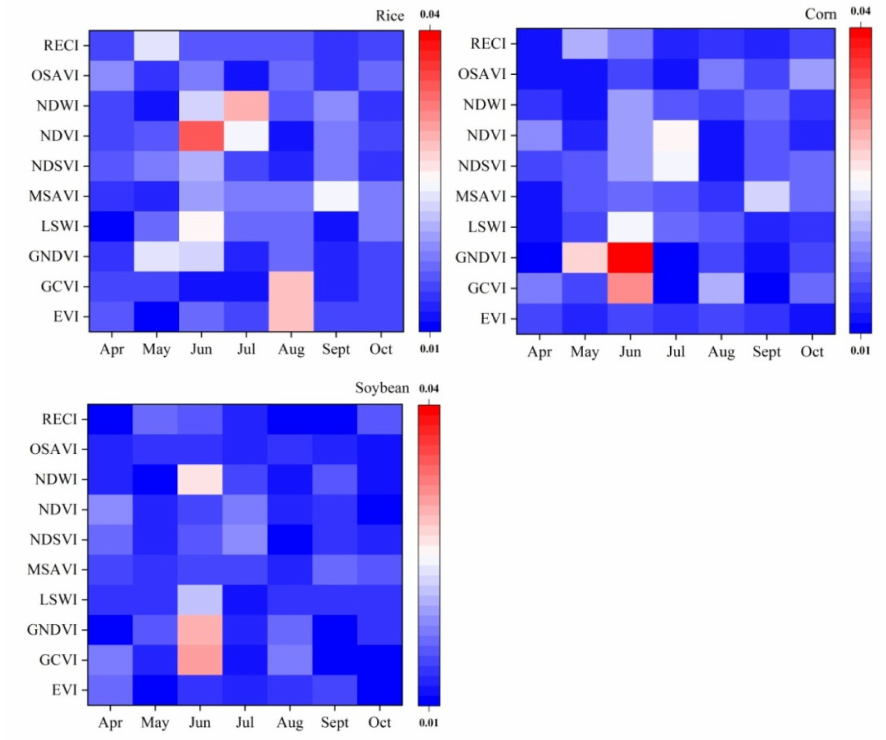
Figure 5. Feature